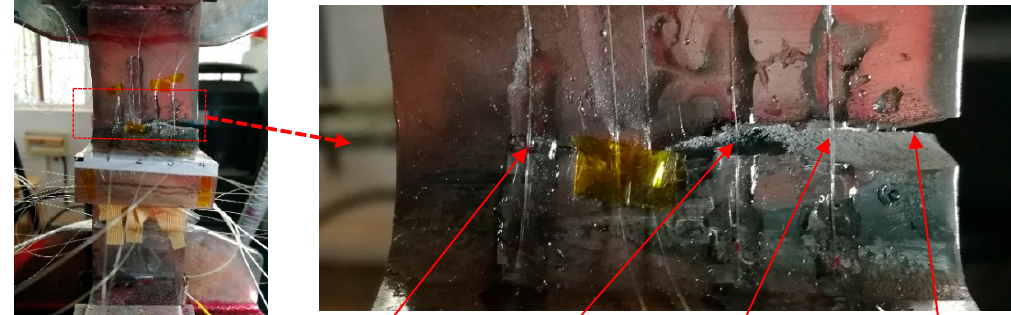
Figure 9. Testing points arrangement and specimen fracture.